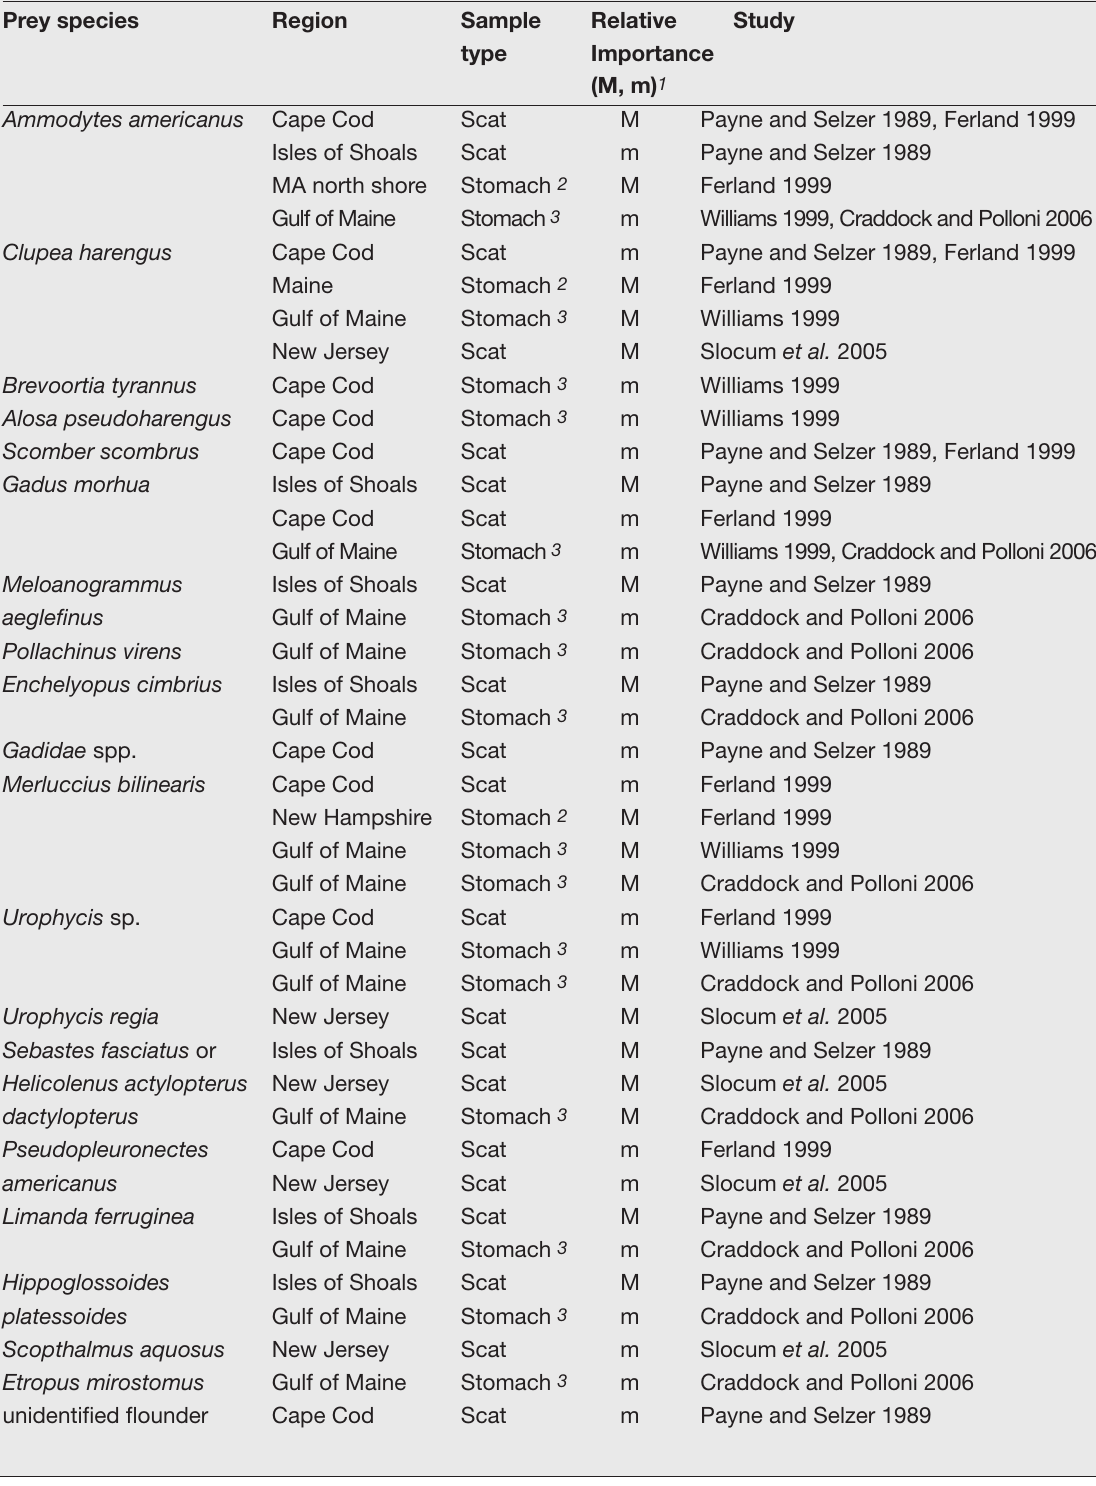
Table 3. Prey items found in harbour seal scat and stomach collections between 1989 and 2005. Prey